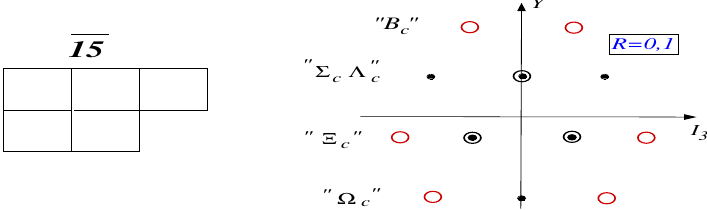
Figure 5. (Color online) Young tableaux and particle content of the anti-decapentaplet ( 15 ). Black circles denote ordinary diquarks whose quantum numbers relate to two quark states. Double circles indicate two states with different R quantum numbers. Red circles denote exotic states that cannot be built from two quarks.